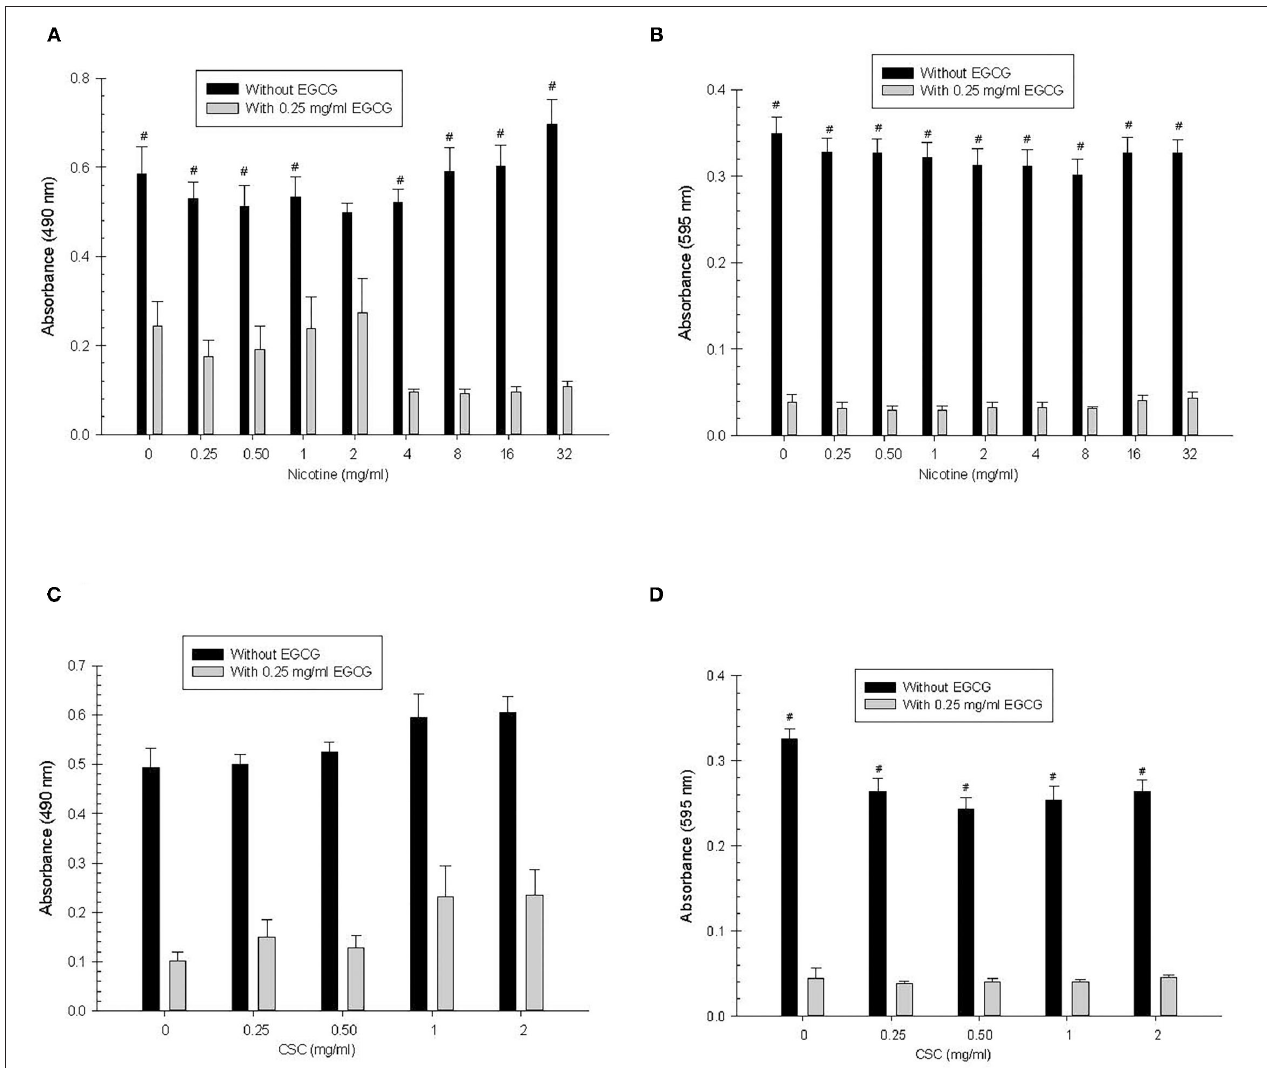
FIGURE 3 | Tertiary S. mutans biofilm (A,C) and total absorbance (B,D) nicotine/CSC exposure effects. # Indicates significant differences between growth with 0.25 mg/ml of EGCG and without EGCG. * and @ indicates significant differences between 0 mg/ml nicotine/CSC and other concentrations with 0.25 mg/ml of EGCG and without EGCG,